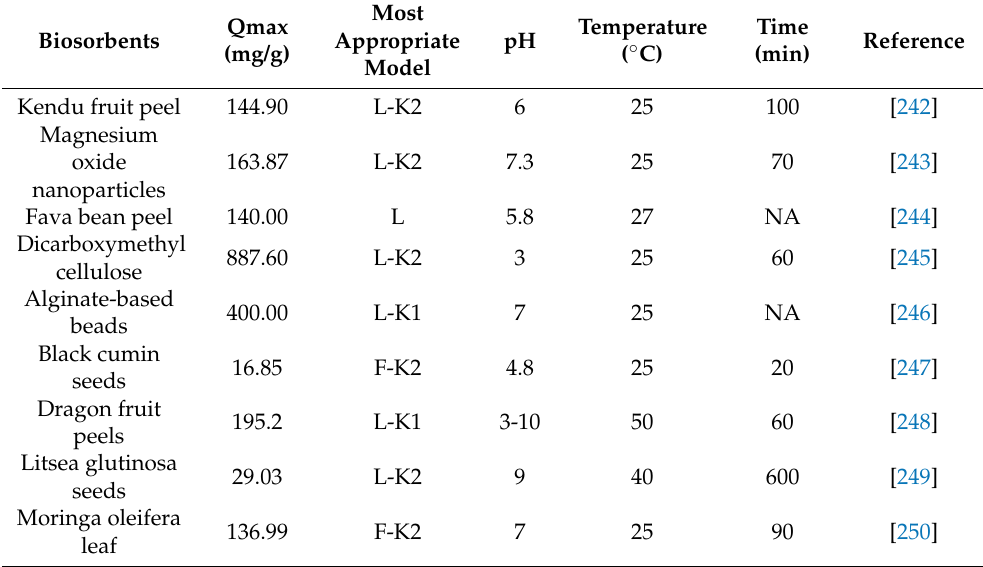
Table 12. Summary of bio-waste-derived adsorbent studies in 2020.